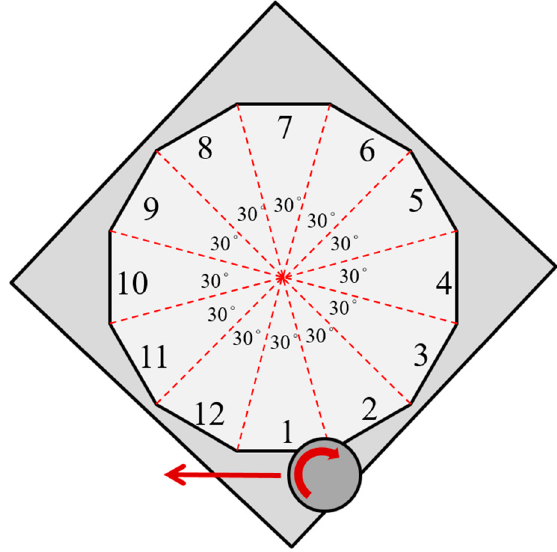
Figure 26. Cutting method. Table 1. Technical milling